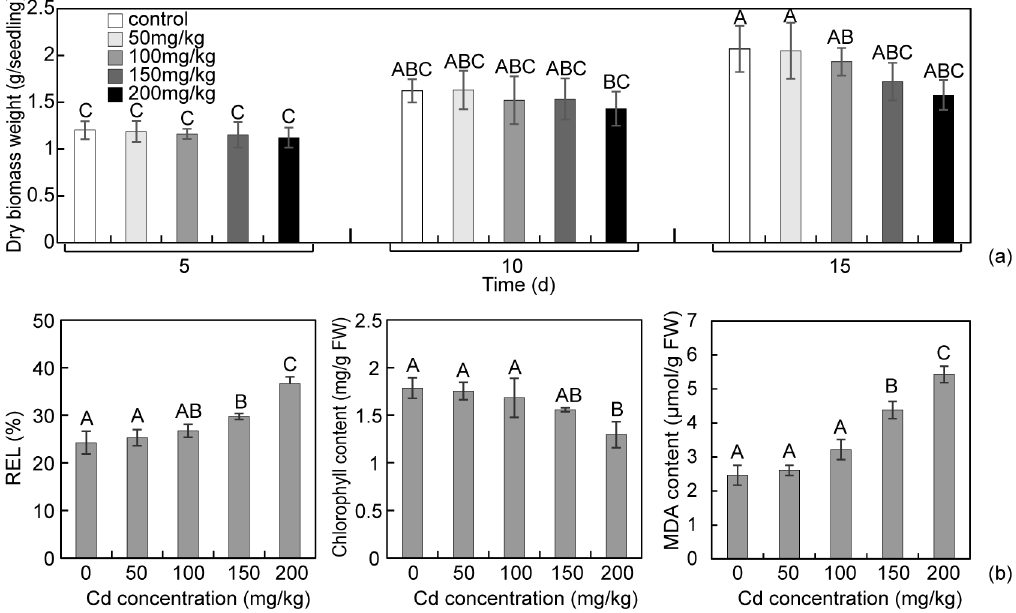
Fig 1. Dry biomass production (a) and physiological indexes performance (b) of P . americana plants exposed to 0, 50, 100, 150, 200 mg CdCl 2 /kg dry soil. All values are the mean of triplicates( ± SD). Different capital letters above the column indicate an extremely significantdifference at P < 0.01accordingto the SNK multiple